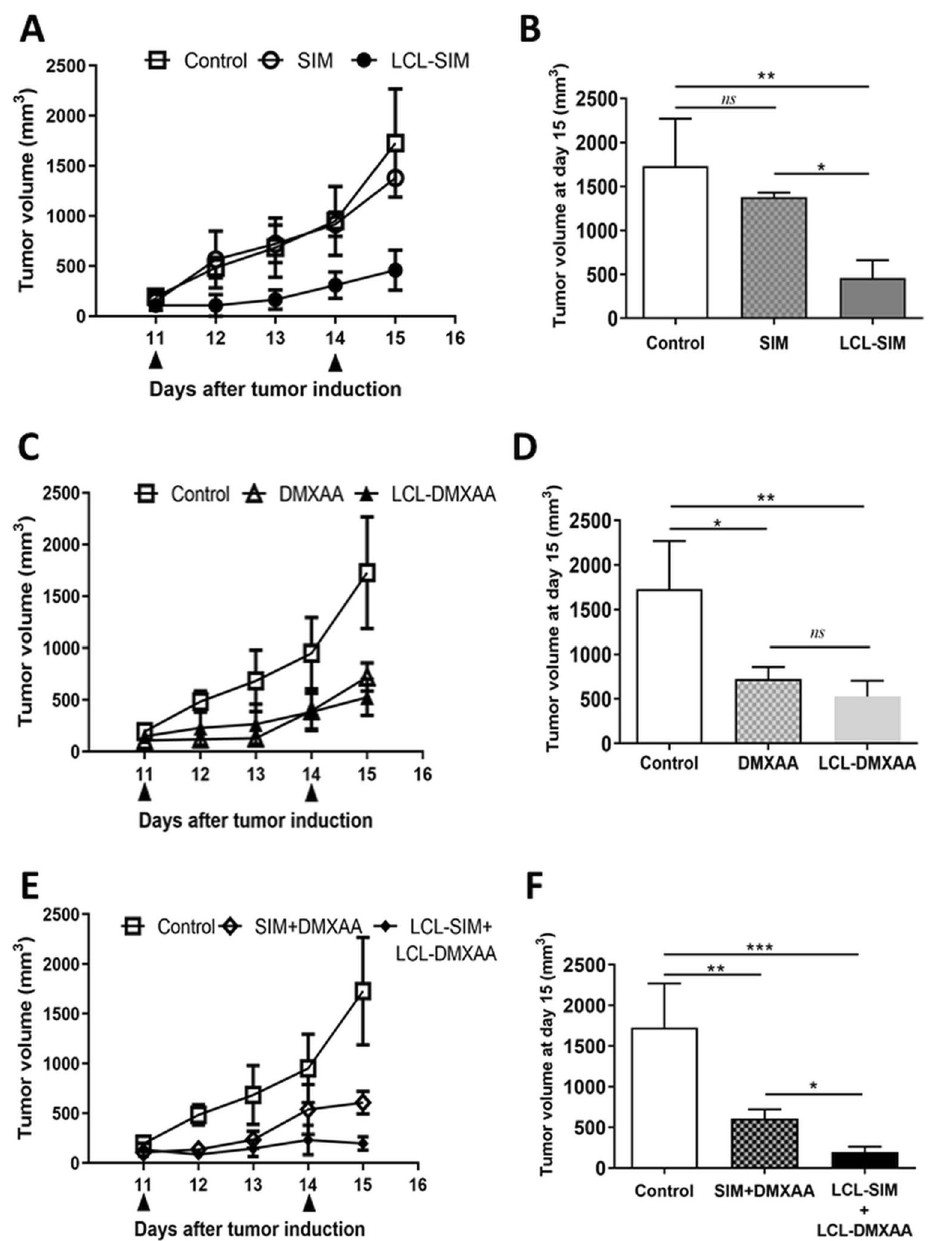
Figure 1. Effects of the combined administration of free and liposome-encapsulated SIM and DMXAA on the growth of s.c . B16.F10 murine melanoma. Mice received two i.v . injections of therapeutic agents at day 11 and day 14, after cancer cell inoculation. Tumor growth curves were presented in panels ( A ), ( C ), and ( E ). Tumor volumes after different treatments at day 15 (when mice were killed) were presented in panels ( B ), ( D ), and ( F ). Control—LCL-treated group; SIM—experimental group treated with 5 mg/kg free SIM; LCL- SIM—experimental group treated with 5 mg/kg SIM as liposome-encapsulated form; DMXAA—experimental group treated with 14 mg/kg free DMXAA; LCL-DMXAA—experimental group treated with 14 mg/kg DMXAA as liposome-encapsulated form; SIM + DMXAA—experimental group treated with 5 mg/kg free SIM and 14 mg/kg free DMXAA; LCL-SIM + LCL-DMXAA—experimental group treated with 5 mg/kg SIM and 14 mg/kg DMXAA as liposome-encapsulated forms. Results were expressed as mean ± SD of